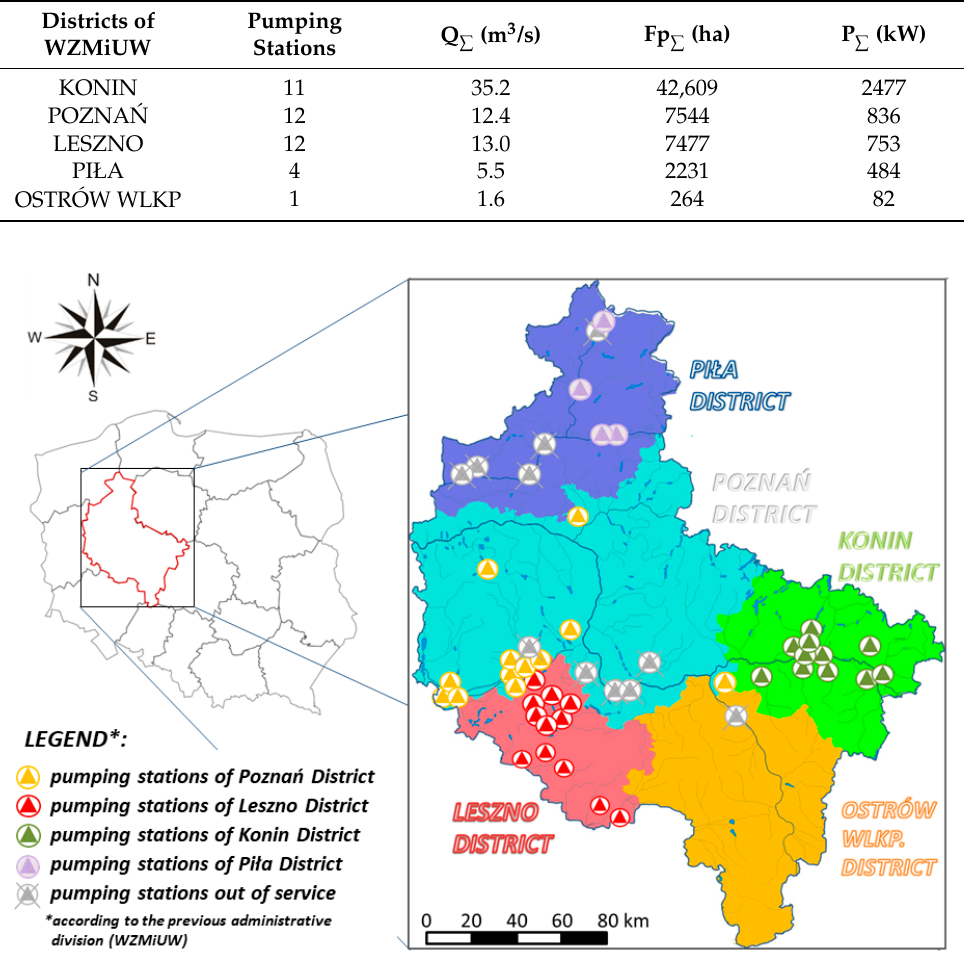
Figure 2. Drainage pumping stations in Greater Poland Voivodeship, administered by WZMiUW (currently by RZGW).